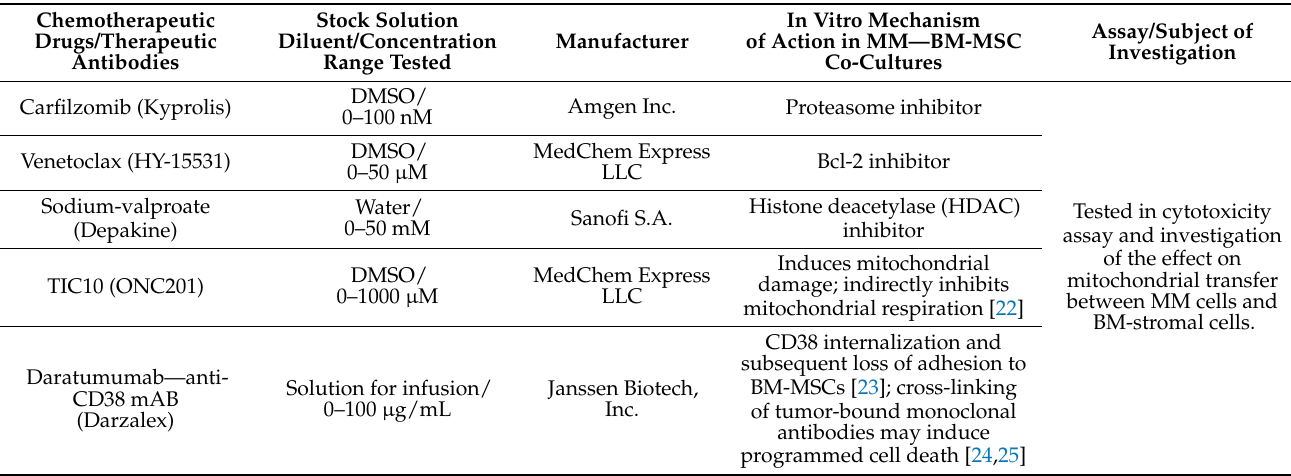
Table 2. Therapeutic antibodies, chemotherapeutic drugs, and inhibitors used in this study. Chemotherapeutic Drugs/Therapeutic